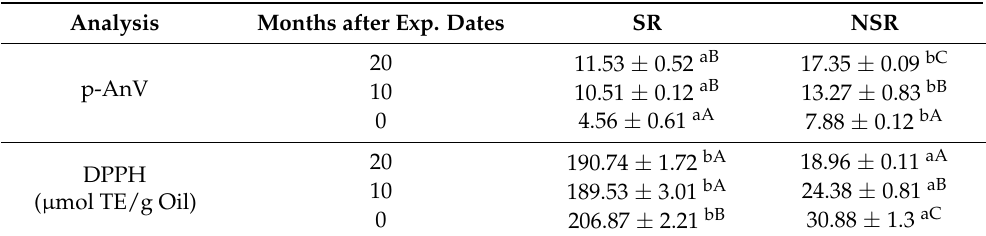
Table 1. Chemical characteristics of raspberry seed oil based on p-anisidine value (p-AnV) and DPPH radical scavenging